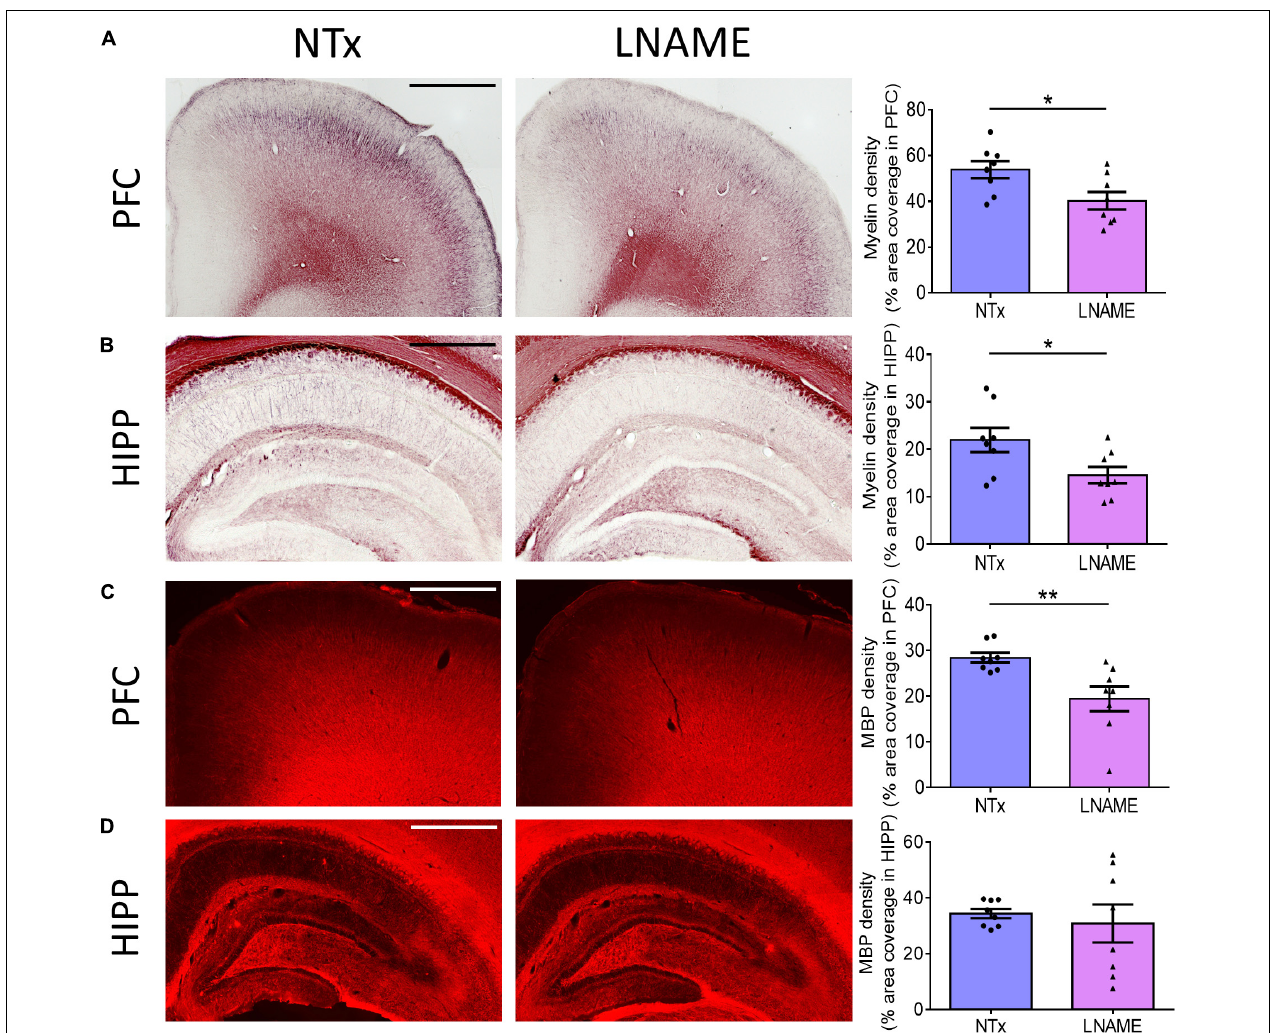
FIGURE 4 | Transient hypertension promotes irreversible loss of myelin density. (A) Representative images (left and middle) and quantification (right) of myelin density in PFC: L-NAME-treated rats had lower myelin density ( p = 0.023); scale bar = 1,250 µ m. (B) Representative images (left and middle) and quantification (right) of myelin density in HIPP: L-NAME-treated rats had lower myelin density ( p = 0.031); scale bar = 750 µ m. (C) Representative images (left and middle) and quantification (right) of MBP fluorescence coverage in PFC: L-NAME treatment decreased coverage of MBP immunoreactivity ( p = 0.008); scale bar = 1,000 µ m. (D) Representative images (left and middle) and quantification (right) of MBP fluorescence coverage in HIPP: MBP immunoreactivity coverage was unchanged ( p = 0.621); scale bar = 875 µ